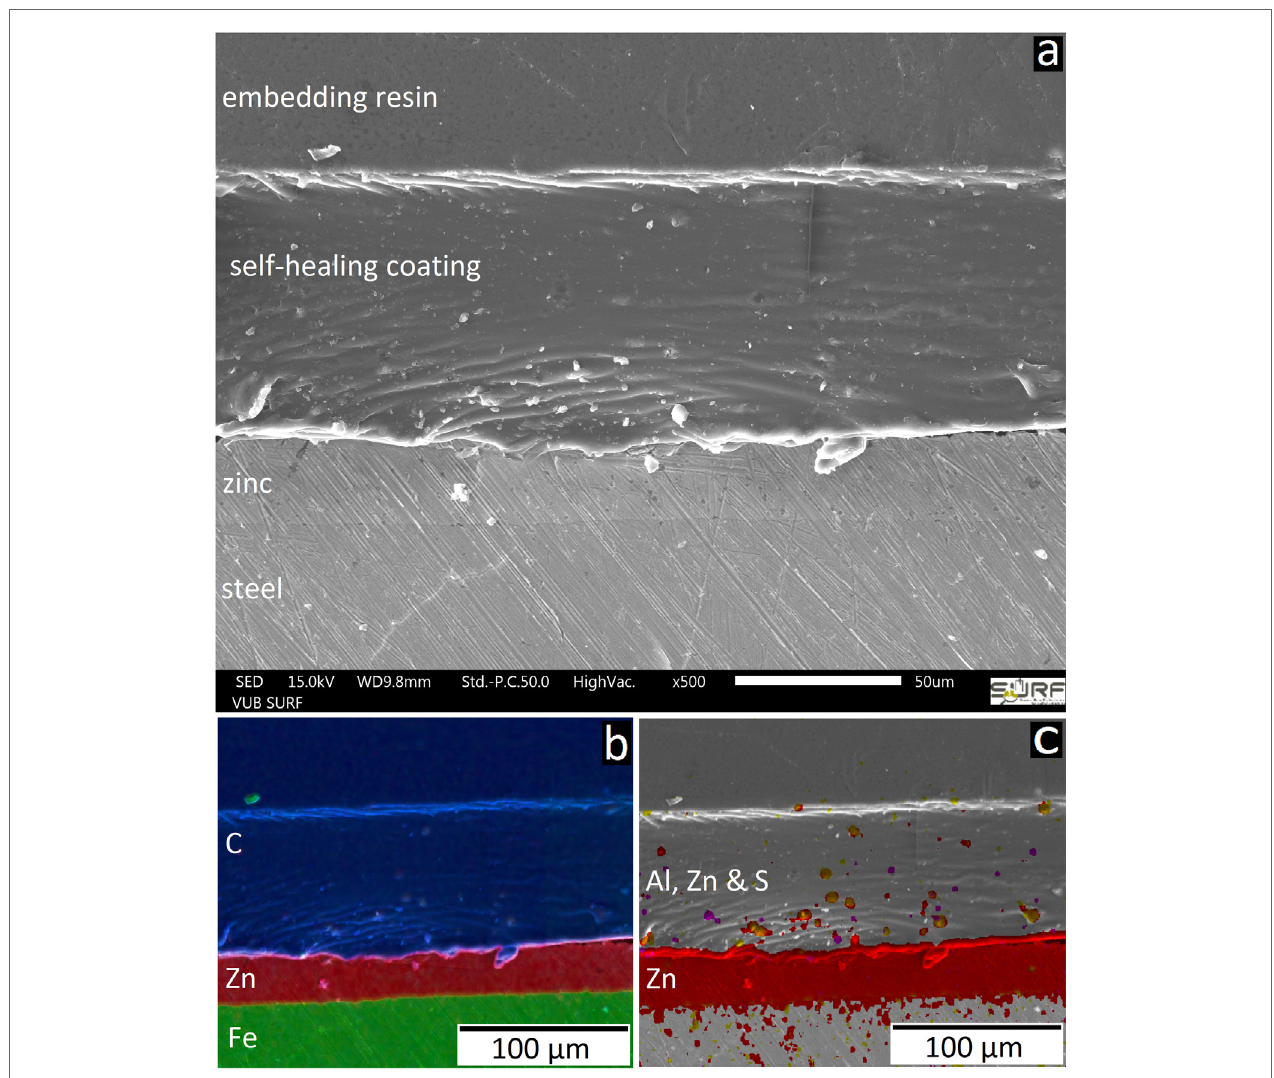
FigUre 1 | The seM image (a) shows the structure of the Mash sample in cross-section . EDX mappings show the different layers (B) and the finely distributed corrosion inhibitor containers (c)